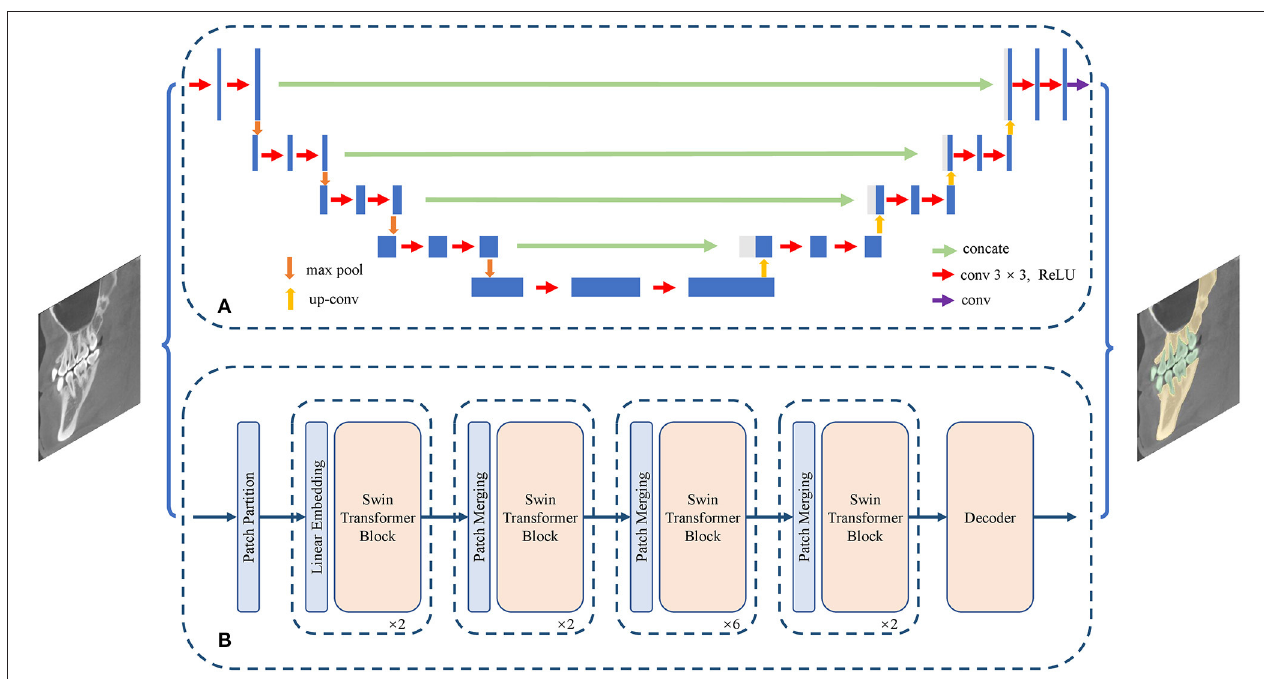
FIGURE 4 | Structure of semantic segmentation network. (A) The CNN-based semantic segmentation approach, from UNet. (B) The Transformer-based semantic segmentation approach, from